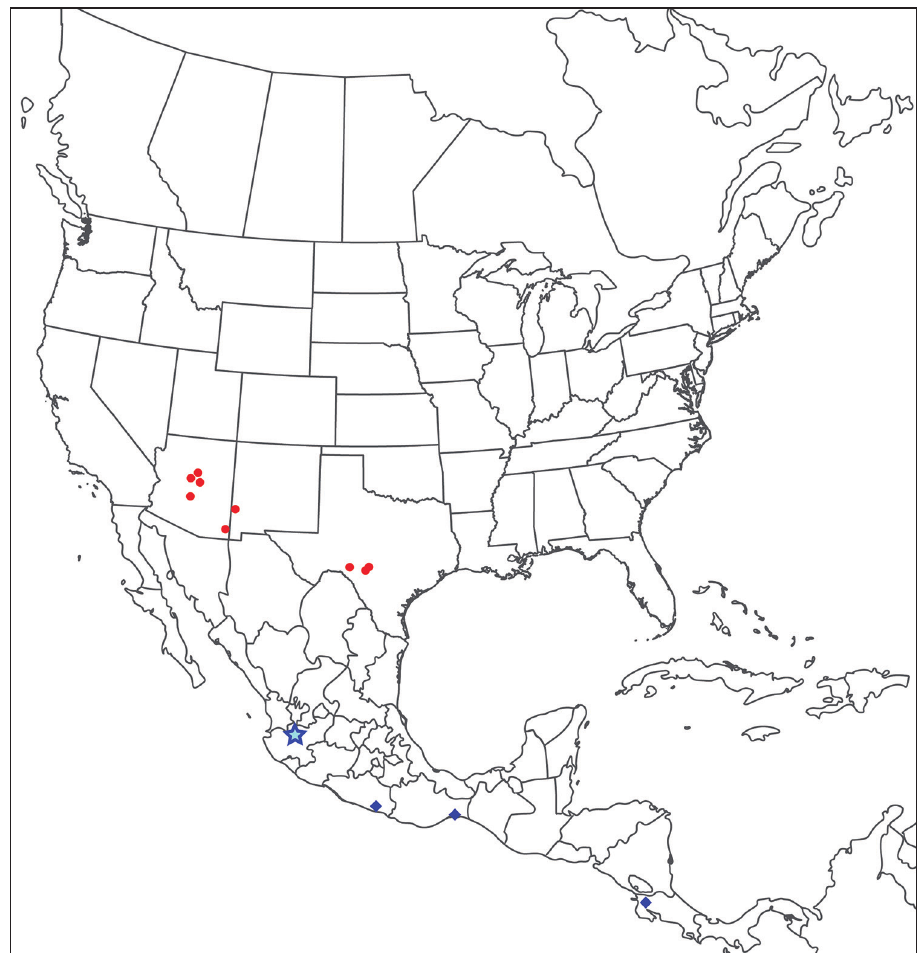
Figure 208. Torrenticola rala distribution. Red dots represent material examined; blue diamonds repre- sent previous records (Cook 1980); blue star represents holotype locality (Cook